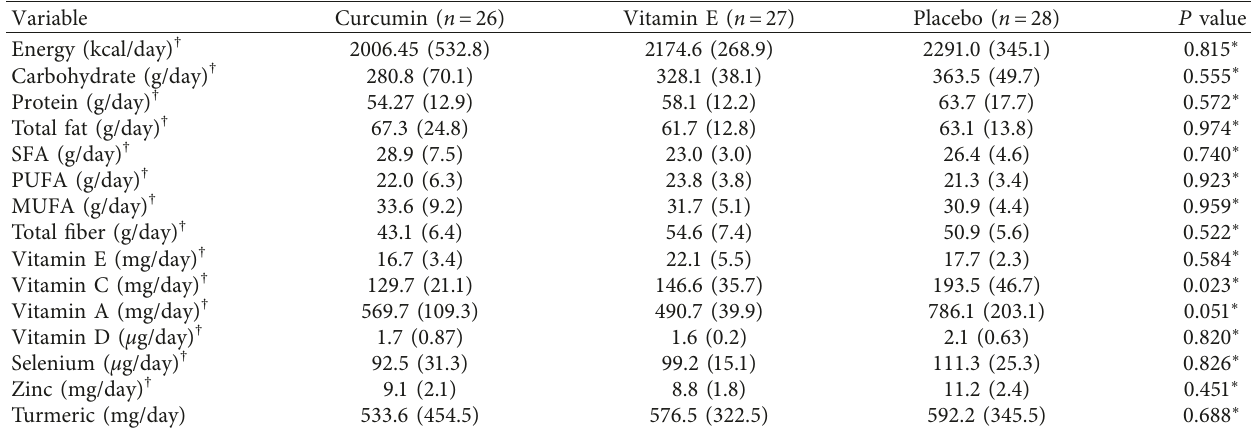
Table 2: Comparison of dietary intake between participants among the study